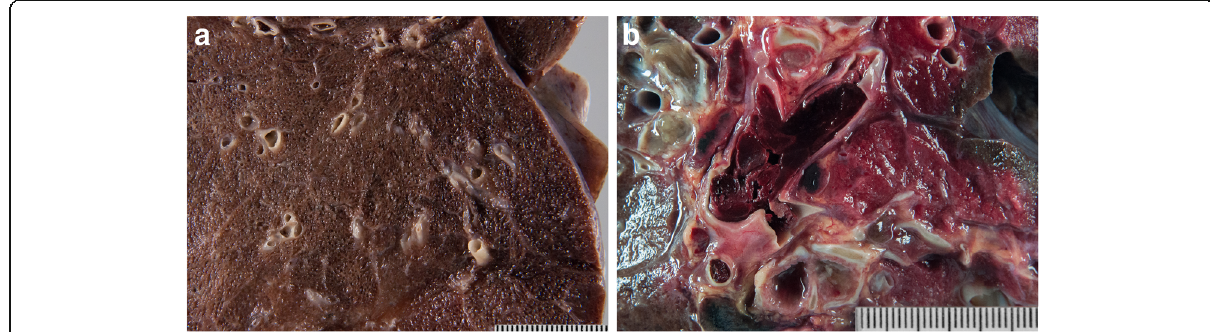
Fig. 4 Gross Images of a COVID-19 lung with a interstitial edema and congestion; b pulmonary embolism in